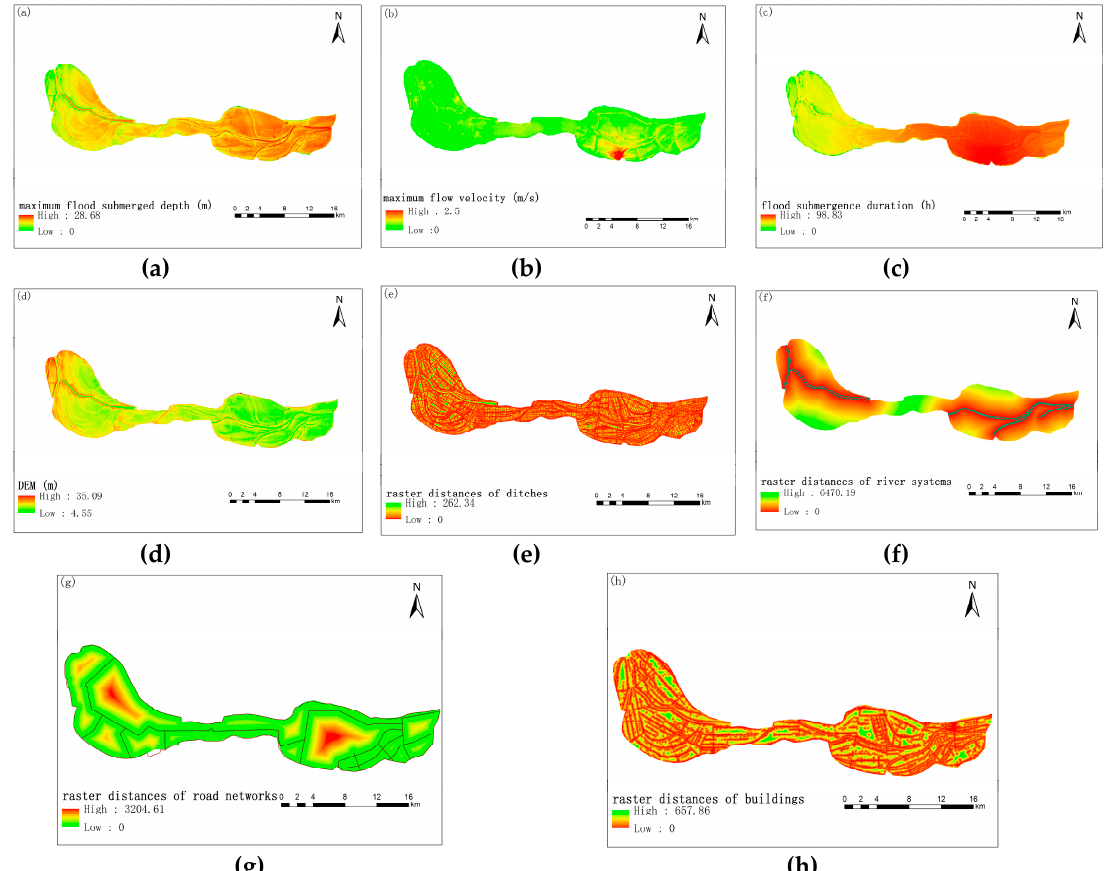
Figure 8. Maps of various flood hazard risk (FHR) indicators. ( a ) maximum flood submerged depth, ( b ) maximum flow velocity, ( c ) flood submergence duration, ( d ) digital elevation model (DEM), ( e ) raster distances of ditches, ( f ) raster distances of river systems, ( g ) raster distances of road networks and ( h ) raster distances of buildings.